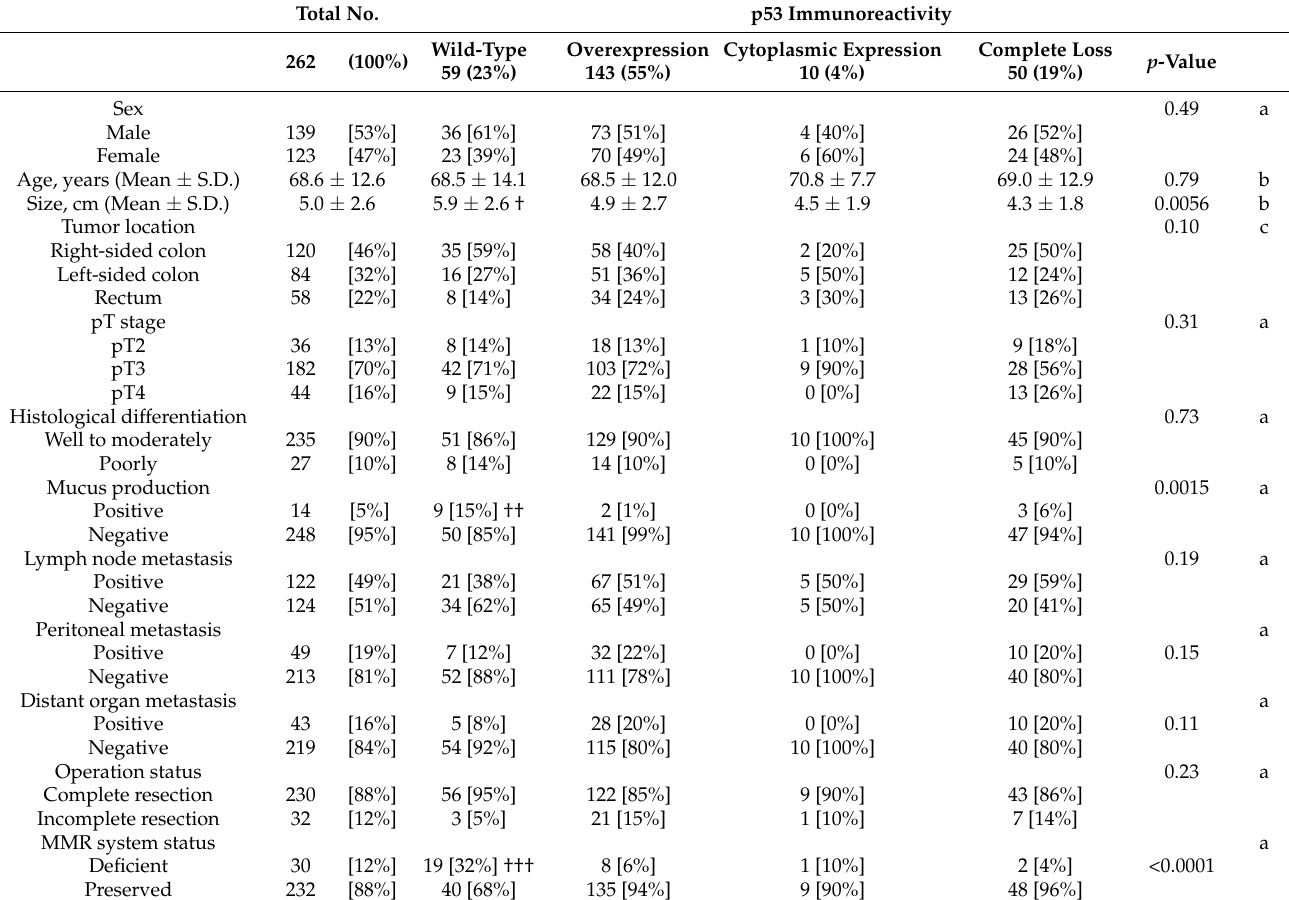
Table 1. Association between p53 immunoreactivity and clinicopathological features.